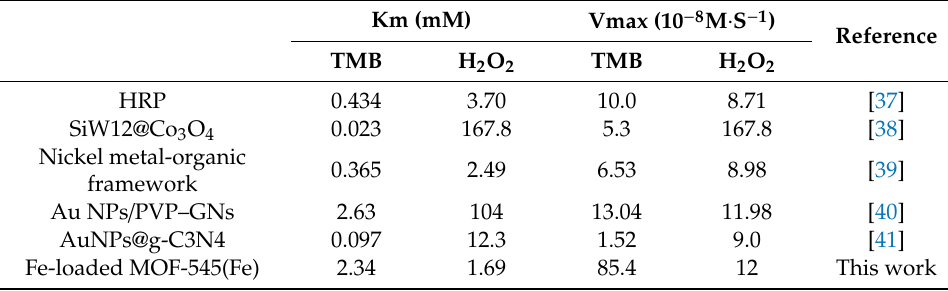
Figure 4. Steady-state kinetic assay of Fe-loaded MOF-545(Fe). The reaction was measured using 1.0 mg·mL − 1 Fe-loaded MOF-545(Fe) in pH 4.0 buffer at 20 °C. ( A ) The concentration of H 2 O 2 is 0.5 mM. ( B ) The concentration of TMB was 0.05 mM. Table 1. Kinetic parameters for di ff erent POD-like activity.